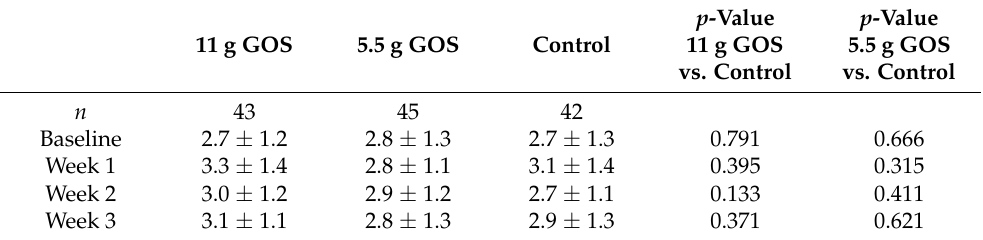
Table 3. Average stool consistency per week (Bristol Stool Scale Score) of ITT Population during the intervention (mean ± SD). 11 g GOS 5.5 g GOS Control